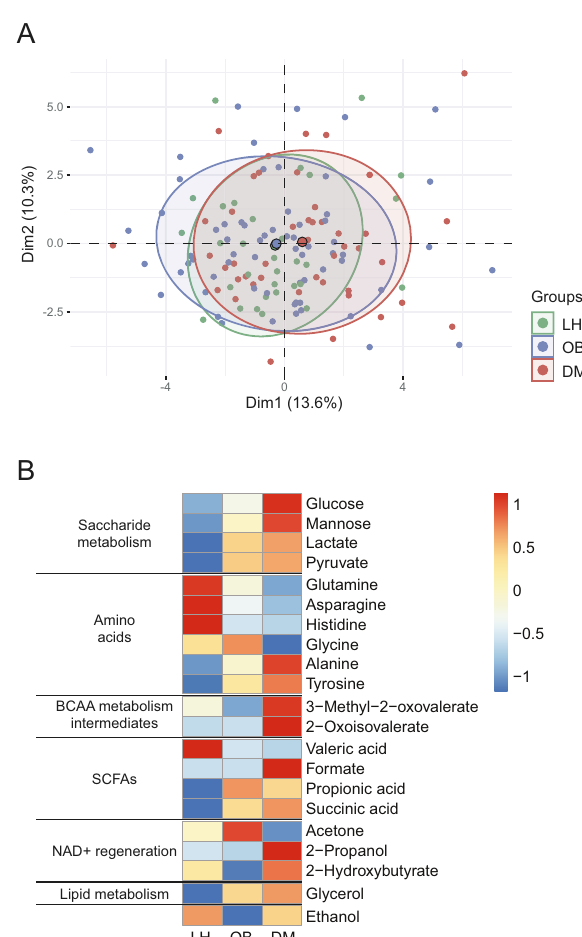
Fig. 3 Serum metabolome composition. A 2D PCA scores plot. The explained variance of each component is included in the axis labels. The large points represent the centroids of each group. B Abundances of signi fi cant metabolites. Each cell then represents the median in each group for the corresponding metabolite. Rows were